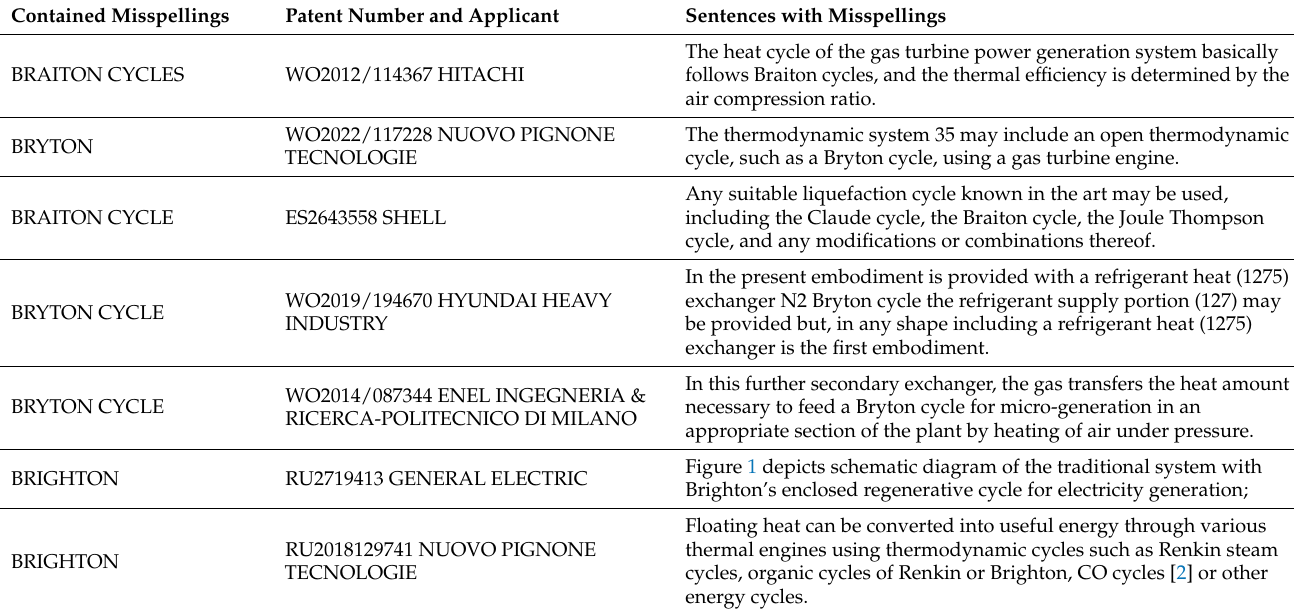
Table 5. Misspellings contained in patents of notorious